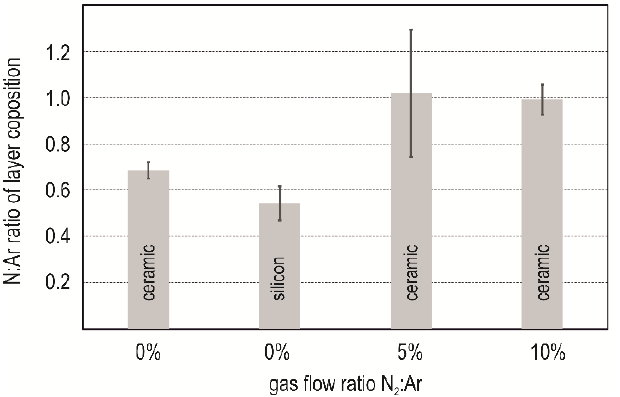
Figure 2. Layer composition derived from energy dispersive X-ray spectroscopy (EDX)